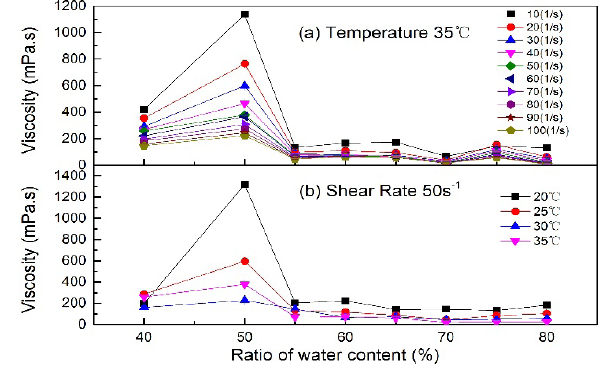
Figure 7: Dependencies of viscosity on the water content in the system of polymer concentration (503mg/L) and (a) temperature (35 ) (b) shear rate (50s -1 ). ℃